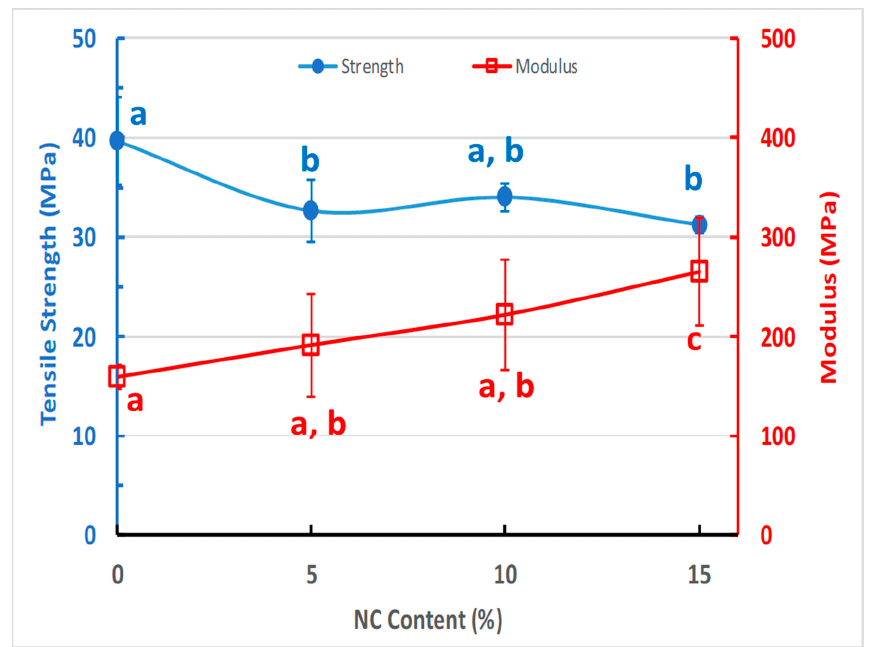
Figure 10. Tensile strength and modulus of elasticity (right axis) of PVA materials as a function of nano-clay content. Error bars indicate the standard deviation in the average test values of 5 samples. Values with the same letter in the same row do not di ff er statistically by Tukey’s test ( p ≤ 0.05).